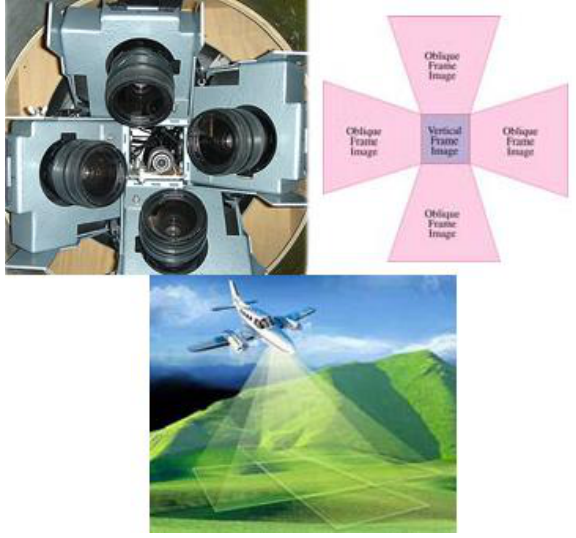
Figure 3. Five camera system (Petrie, 2008)